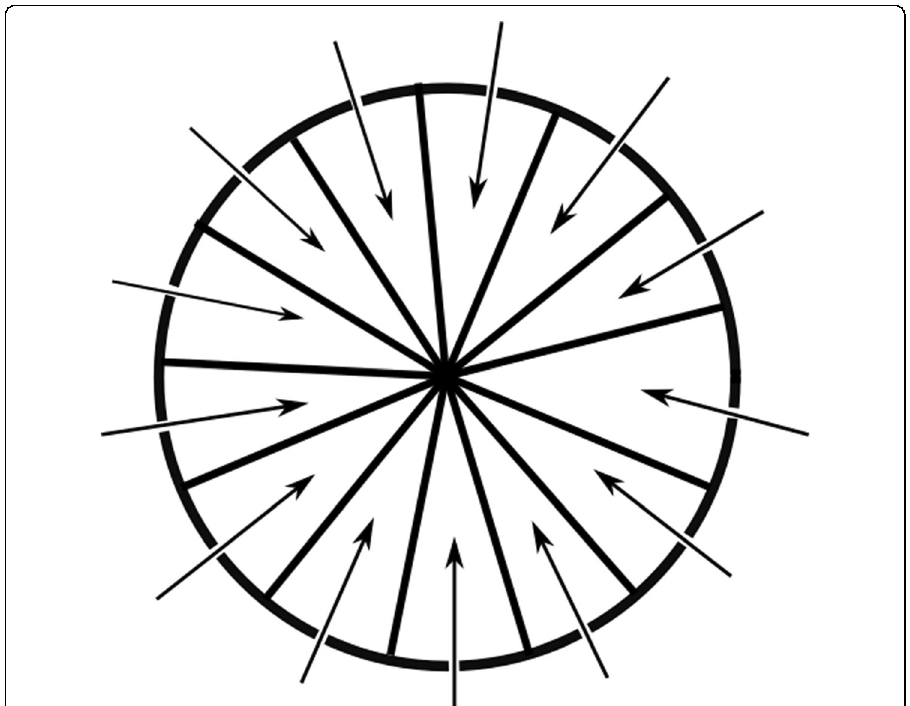
Fig. 16 Legend: Diagonal lines present regions, the small gaps in the outer circle the openings that learners create, the arrows are the way they pass through ‘ inside